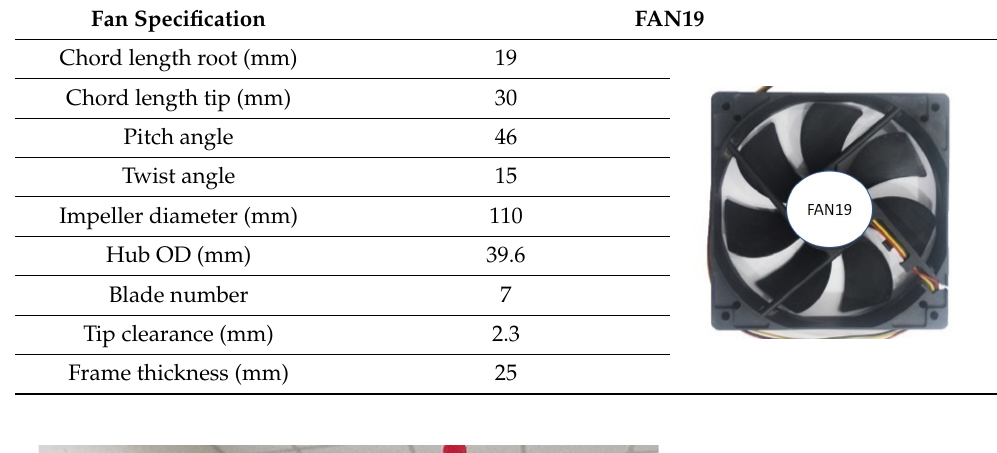
Table 5. Fan characteristics.